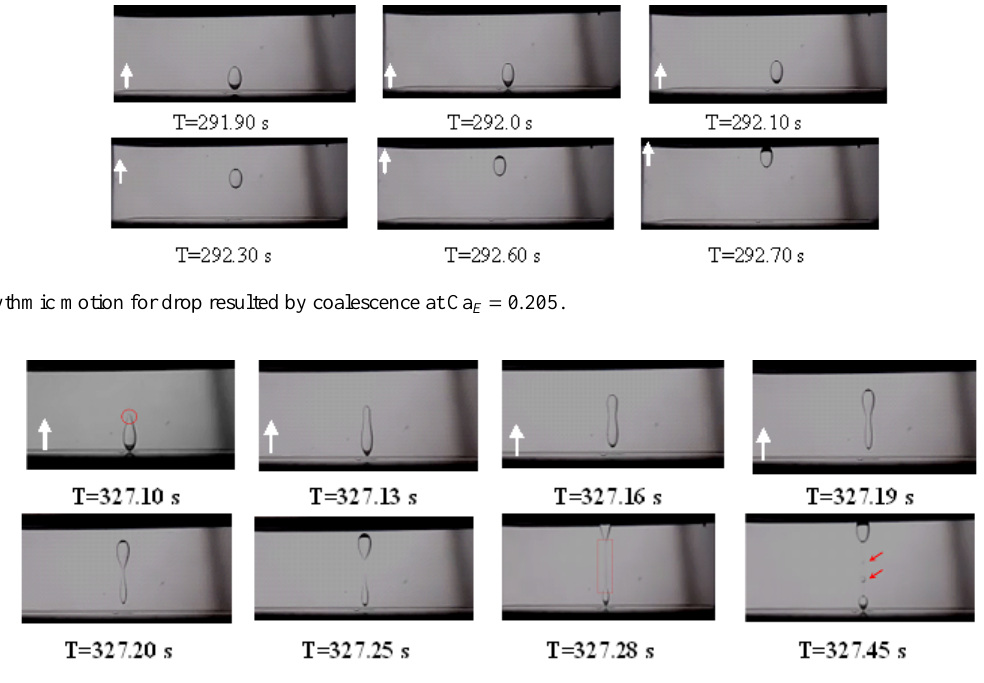
Figure 7a. The mother drop deforms greatly into an elongated shape and divides into two daughter drops along with an expanding liquid bridge between them, which eventually breaks up into more satellite drops (Ca E = 0 . 216).